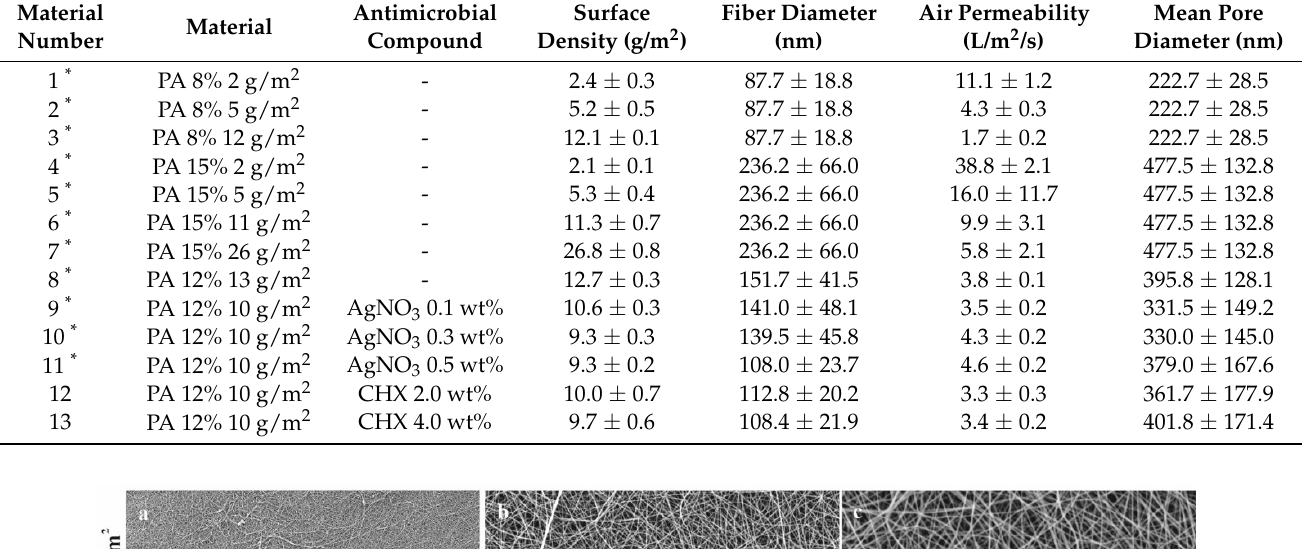
Table 1. Characteristics of tested nanomaterials; * materials were characterized within our previous study [37] from which the parameters (antimicrobial compound, surface density, fiber diameter, and air permeability) were taken.